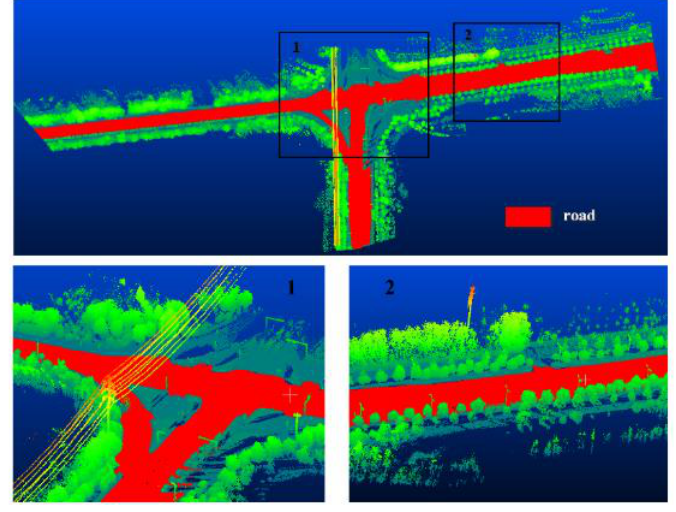
Figure 14. The results of road surface segmentation.